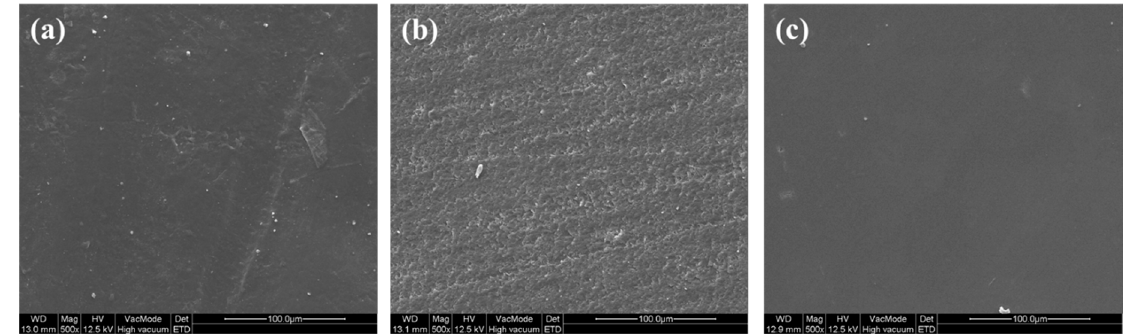
Figure 16. Field-emission scanning electron microscope (FE-SEM) images ( × 500); ( a ) as-3D printed, ( b ) after sanding, and ( c ) after sanding and CMP.